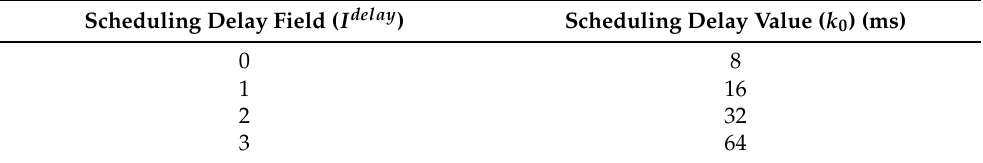
Table 8. The scheduling delay values supported for the uplink scheduling.